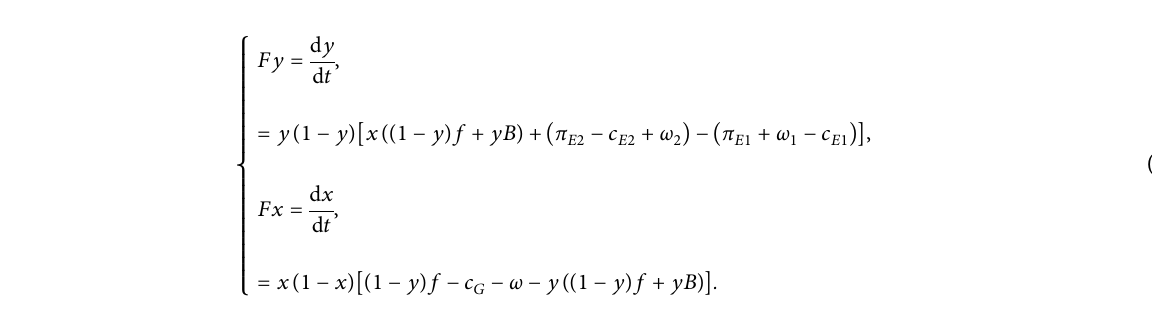
Figure 2: When 0 < ( π and f − c G − ω > 0 Phase